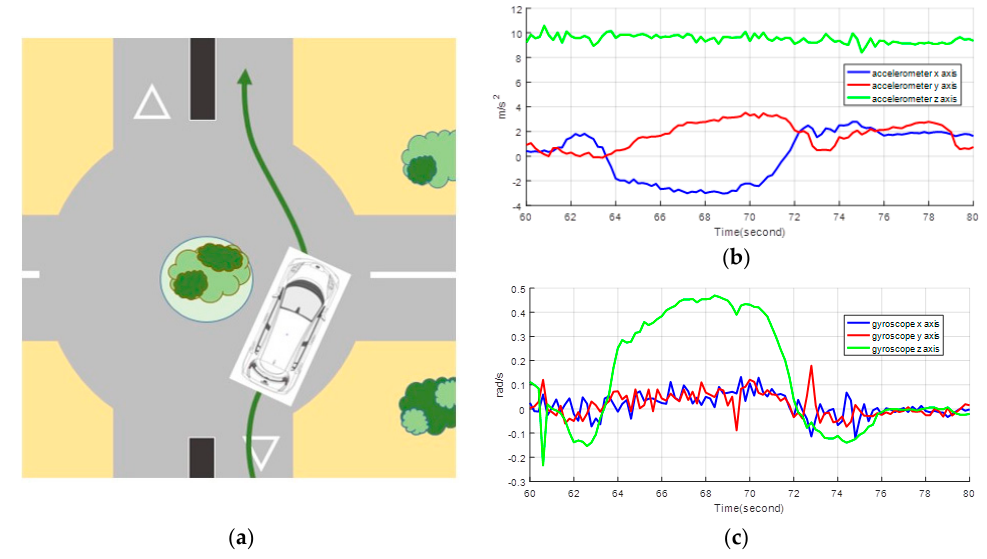
Figure 4. (a) Example of a turn maneuver in a real driving detention. (b) Top plot represents signals Figure 4. ( a ) Example of a turn maneuver in a real driving detention. ( b ) Top plot represents signals from accelerometer sensor. (c) Bottom plot represents signals from gyroscope sensor. from accelerometer sensor. ( c ) Bottom plot represents signals from gyroscope